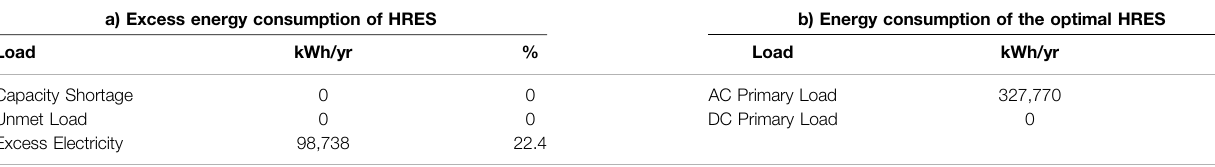
TABLE 11 | Excess Energy and consumption of the optimal HRES.